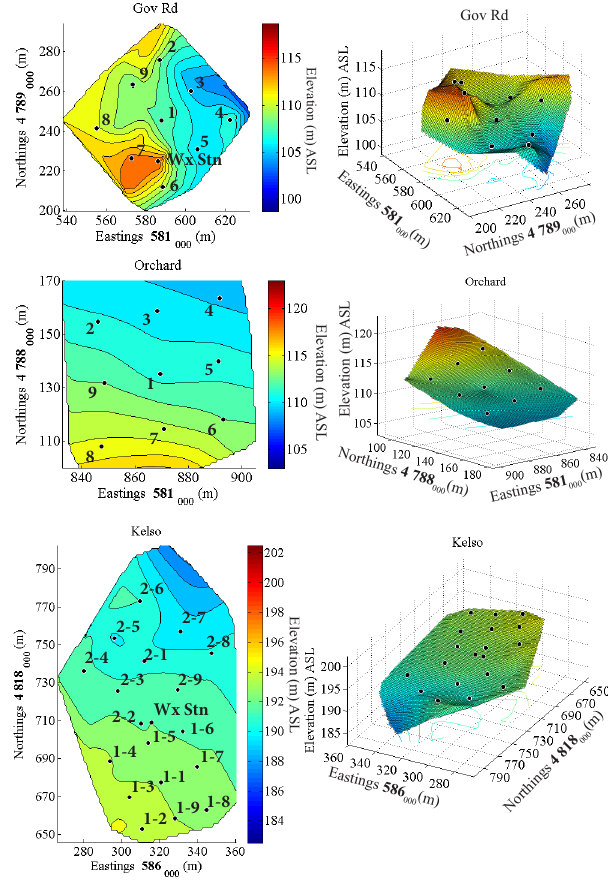
Fig. 4. Topography and layout of the soil moisture arrays at GR (top), OR (middle) and K1/K2 (bottom) as contour plots (left) and surface renderings (right). Contours were derived using natu- ral neighbour interpolation using topographic data collected with an Ashtech MM100 GPS and have an approximate horizontal RMSE of 20cm and vertical RMSE of 50cm. The surface plot vertical ex- aggeration is 3X. Note: surface and contour plots have different ori- entations to enhance the visual interpretation of the surface